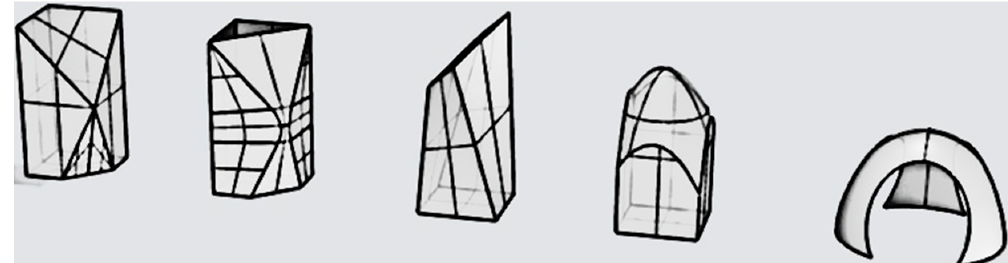
Figure 10. Five different designs of architectural models, including angles and curves for evaluating the performance of any proposed 3DP.